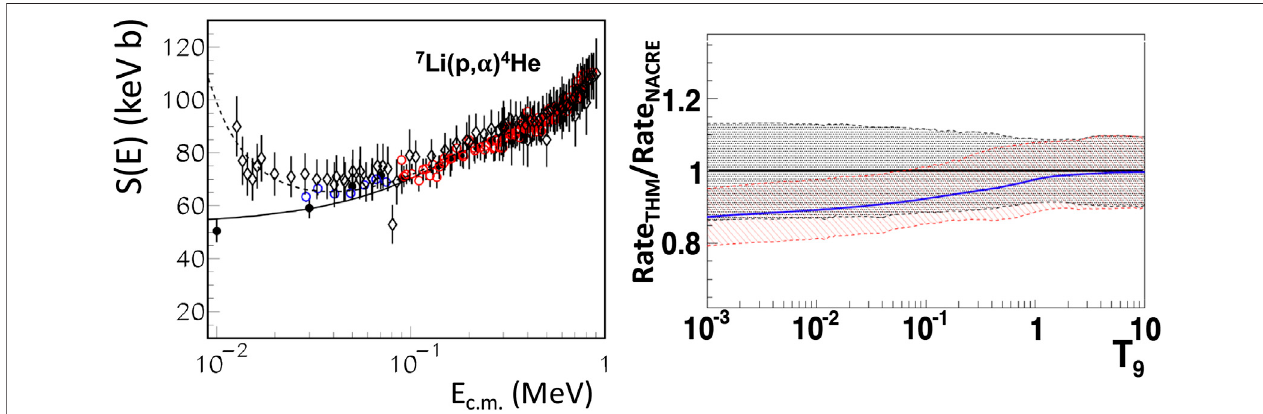
FIGURE 2 | Left panel S(E)-factor for the 7 Li(p, α ) 4 He reaction. Black dots are TH data after the new normalization to Cruz et al. (2008). Red and blue circles representdatafromCruz etal.(2005) and Cruzetal.(2008), respectively. Open diamonds representEngstleret al.(1992) data.Thefulllineistheresultofthepolynomial fi tofTHdata,whilethedashedlineisthe fi ttothelow-energy( < 60 keV)directdataofEngstleretal.(1992)andCruzetal.(2005).RightpanelTheratiobetweentheTHM reaction rate of Lamia et al. (2012a) and the one of NACRE (Angulo et al., 1993) [This fi gure has been adapted from the ones of Lamia et al.